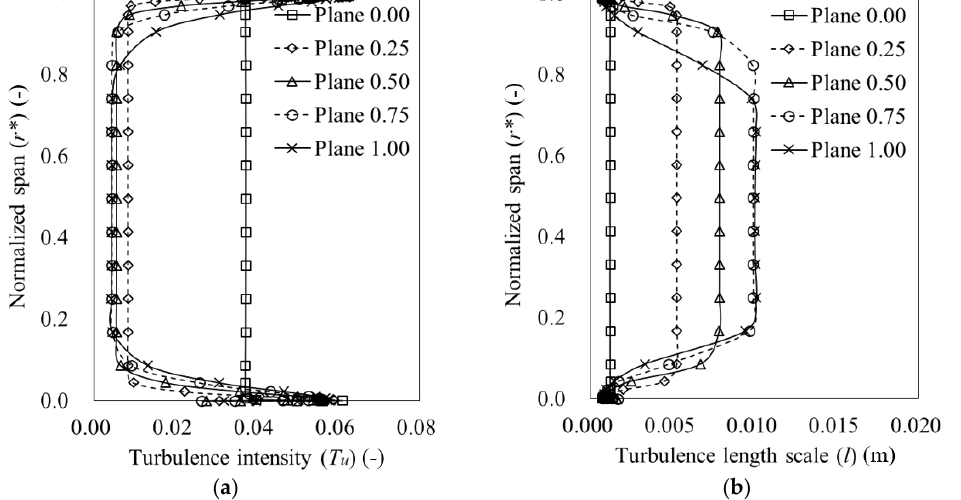
Figure 6. ( a ) Turbulence intensity and ( b ) turbulence length scale from hub to shroud span.